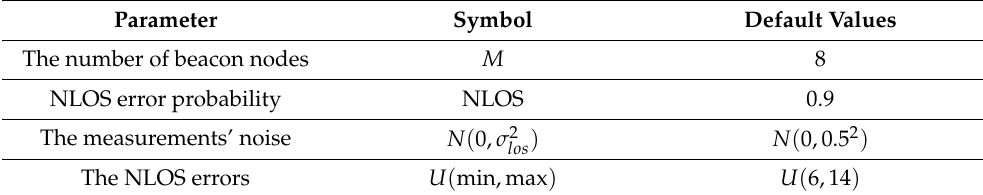
Table 3. Uniform distribution parameter map.